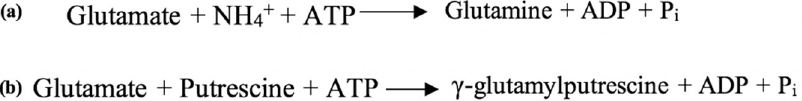
Scheme 1. Schematic reaction of enzyme activities. ( a ) GS biosynthetic reaction. ( b ) Glutamate–pu-